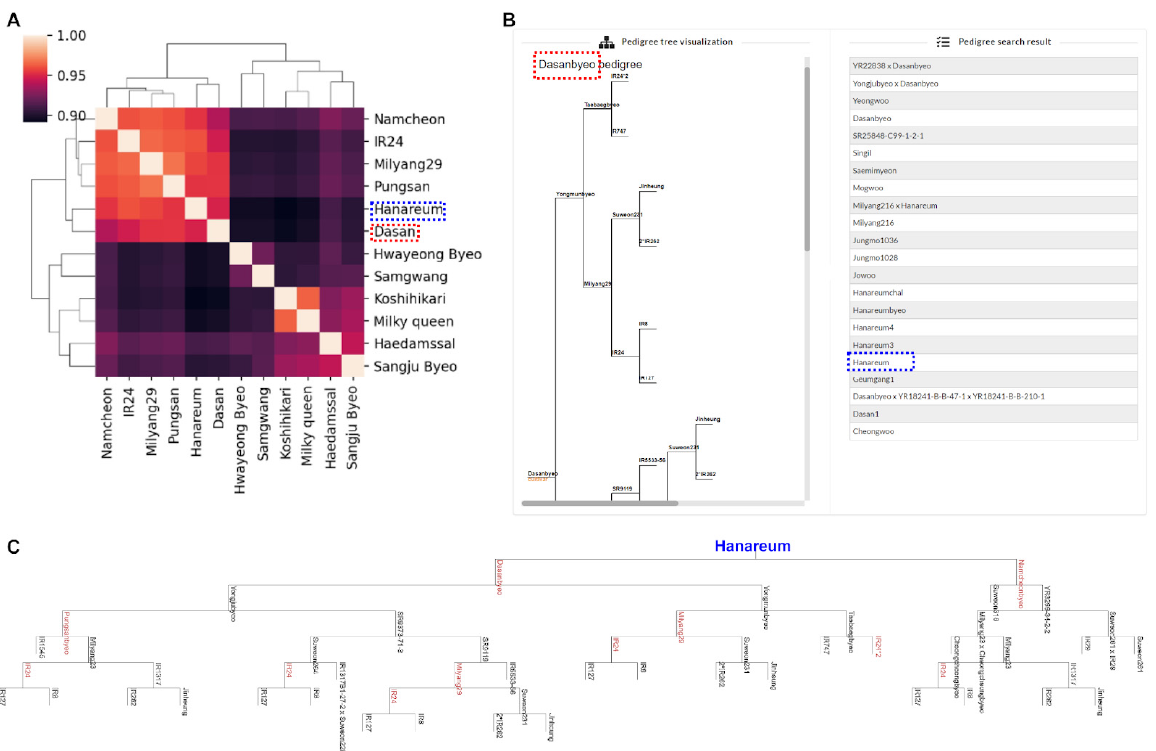
Figure 4. A case study using the RicePedigree database to translate the genomic clustering results based on resequencing data. ( A ) Expected grouping for japonica‑ and indica‑type cultivars, based on genomic SNP analysis. ( B ) RicePedigree search result on query “Dasanbyeo”, showing its pedigree tree and list of cultivars and germplasms that contain “Dasanbyeo” in their pedigree. ( C ) Pedigree of “Hanareum”, showing upstream parental lines in breeding